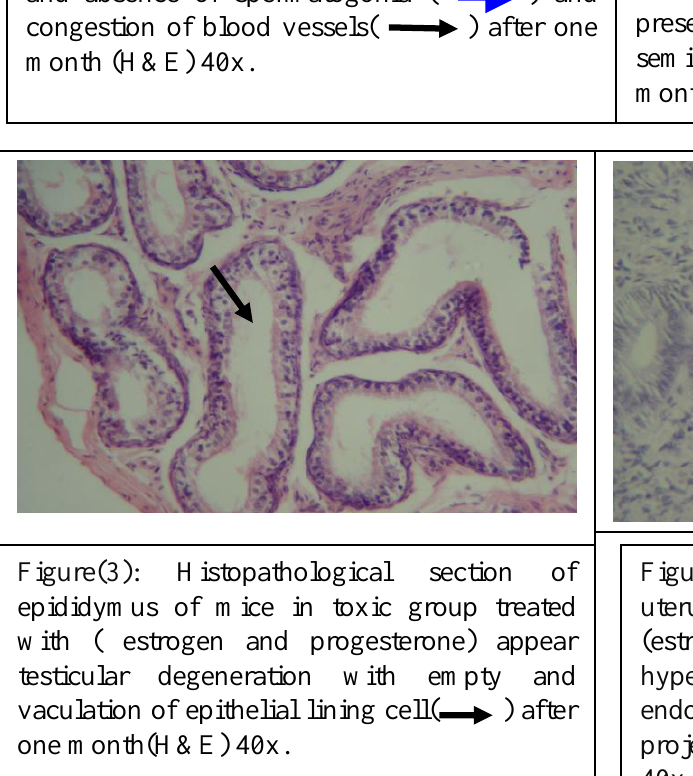
Figure(1): Histopathological section of testis of mice in toxic group treated with (estrogen and progesterone) showed testicular degeneration, and absence of spermatogonia ( ) and congestion of blood vessels( ) after one month (H&E) 40x.